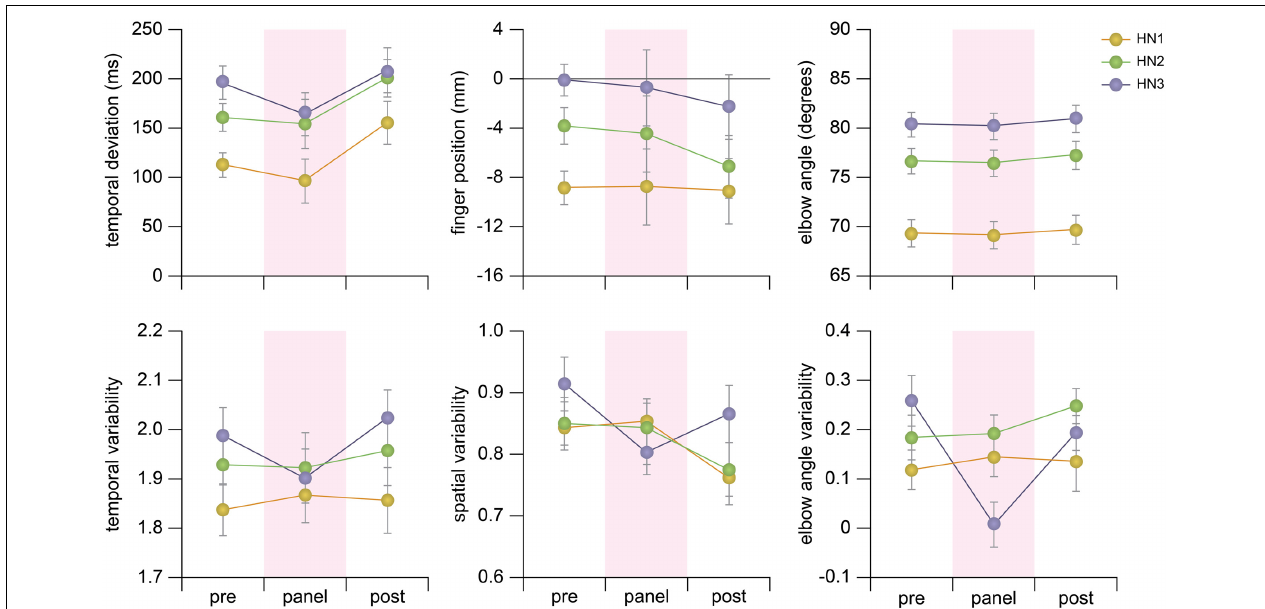
FIGURE 4 | Means and variability of behavioral measures consisting of temporal deviations of the high note, spatial(finger) deviation of the High Note, and the elbow angle at the High Note. The standard